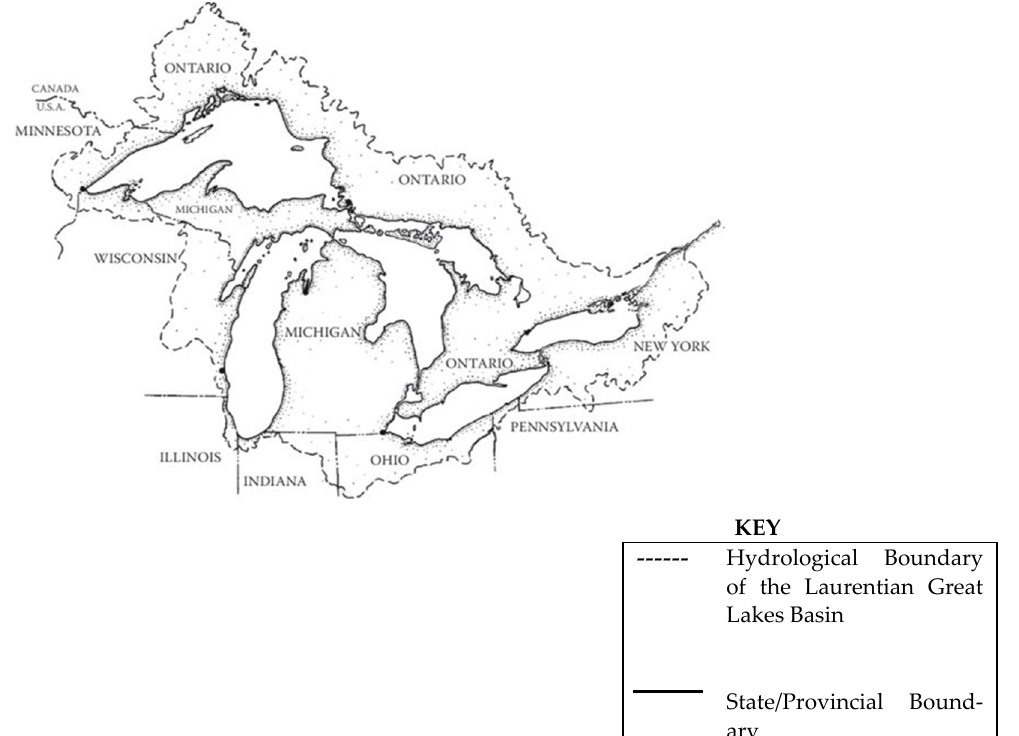
Figure 1. States and provinces within the Laurentian Great Lakes Basin hydrological boundary [4].